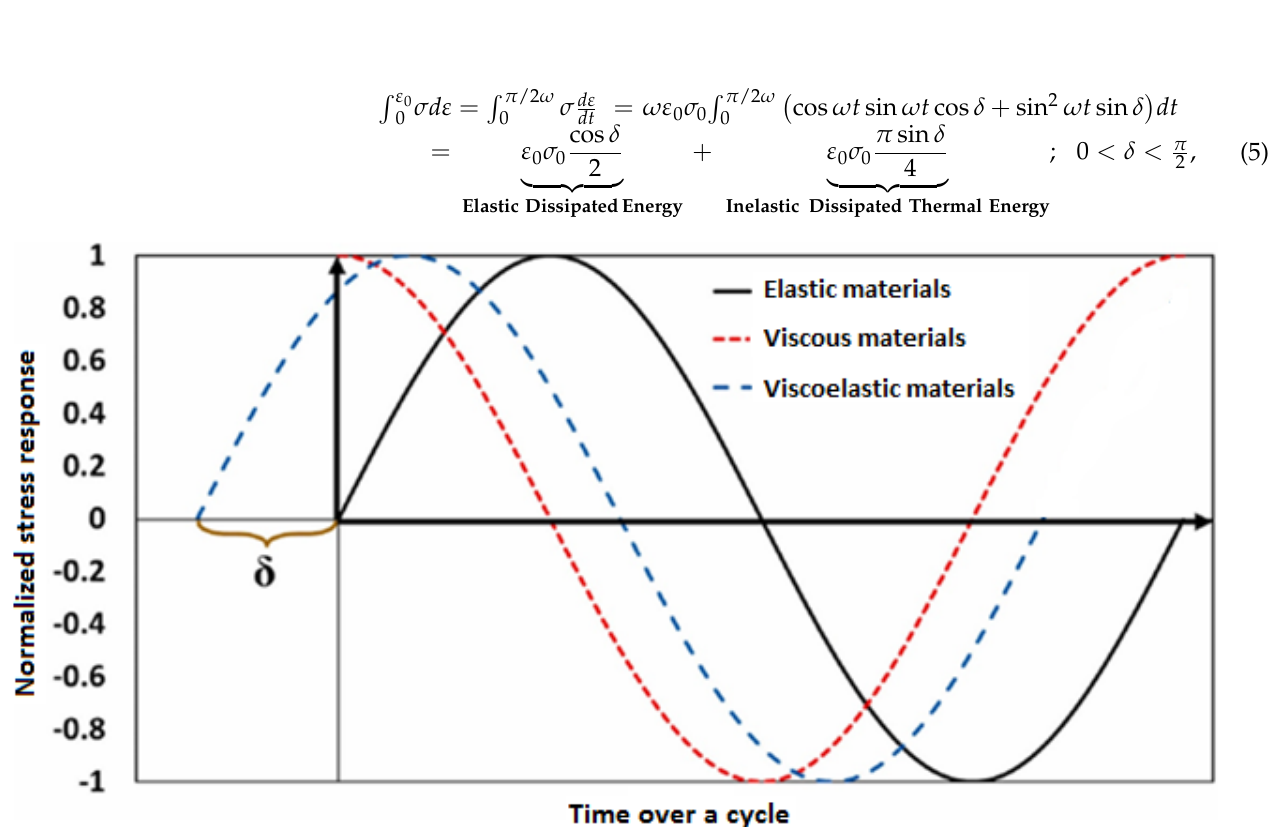
Figure 9. Schematic diagram of resulting stress under applied cyclic strain-driven loading for elastic, vis- cous and viscoelastic materials, adapted with permission from Ref. [49]. Copyright © 2021 Elsevier